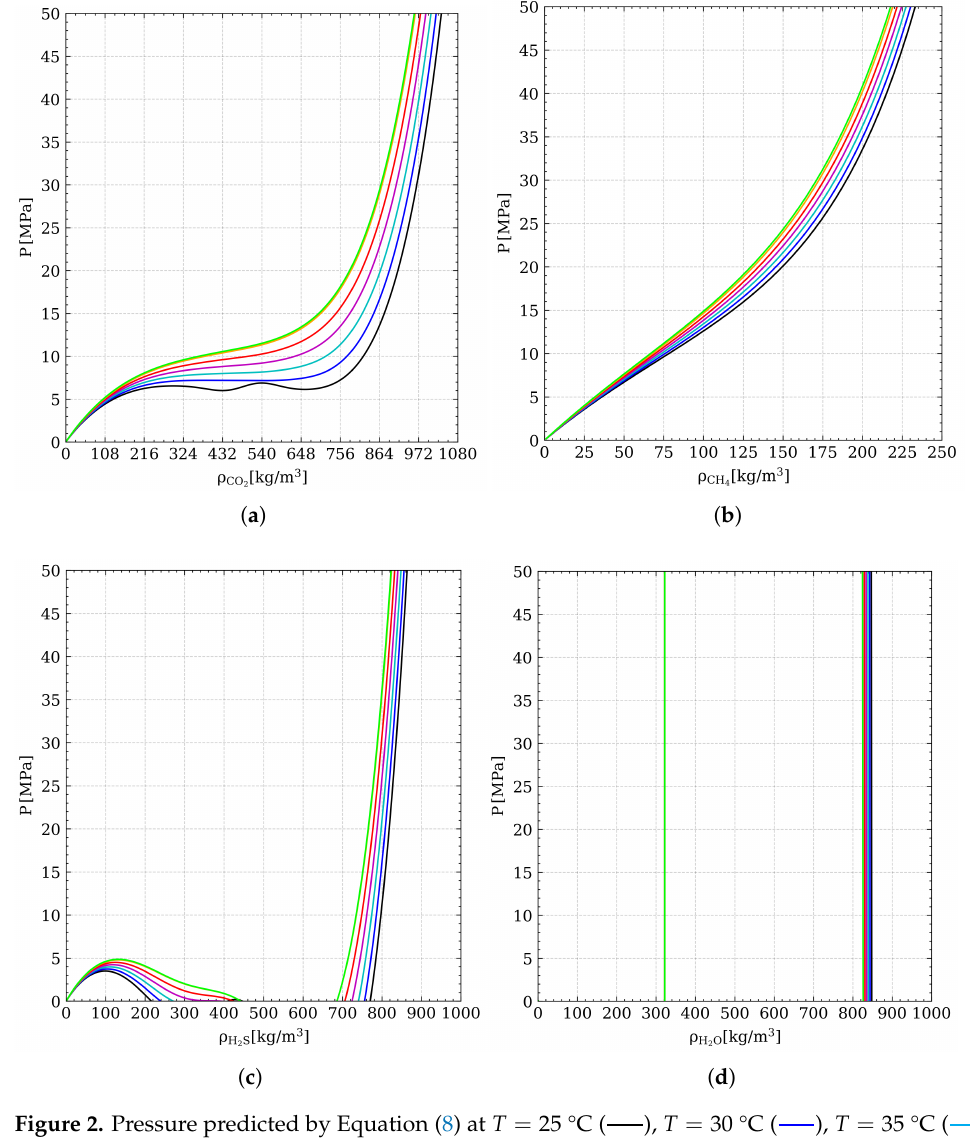
Figure 2. Pressure predicted by Equation (8) at T = 25 °C ( ), T = 30 °C ( ), T = 35 °C ( ), T = 40 °C ( ), T = 45 °C ( ), T = 50 °C ( ) and T = 55 °C ( ). Isotherms for ( a ) carbon dioxide, ( b ) methane, ( c ) hydrogen sulfide and ( d )